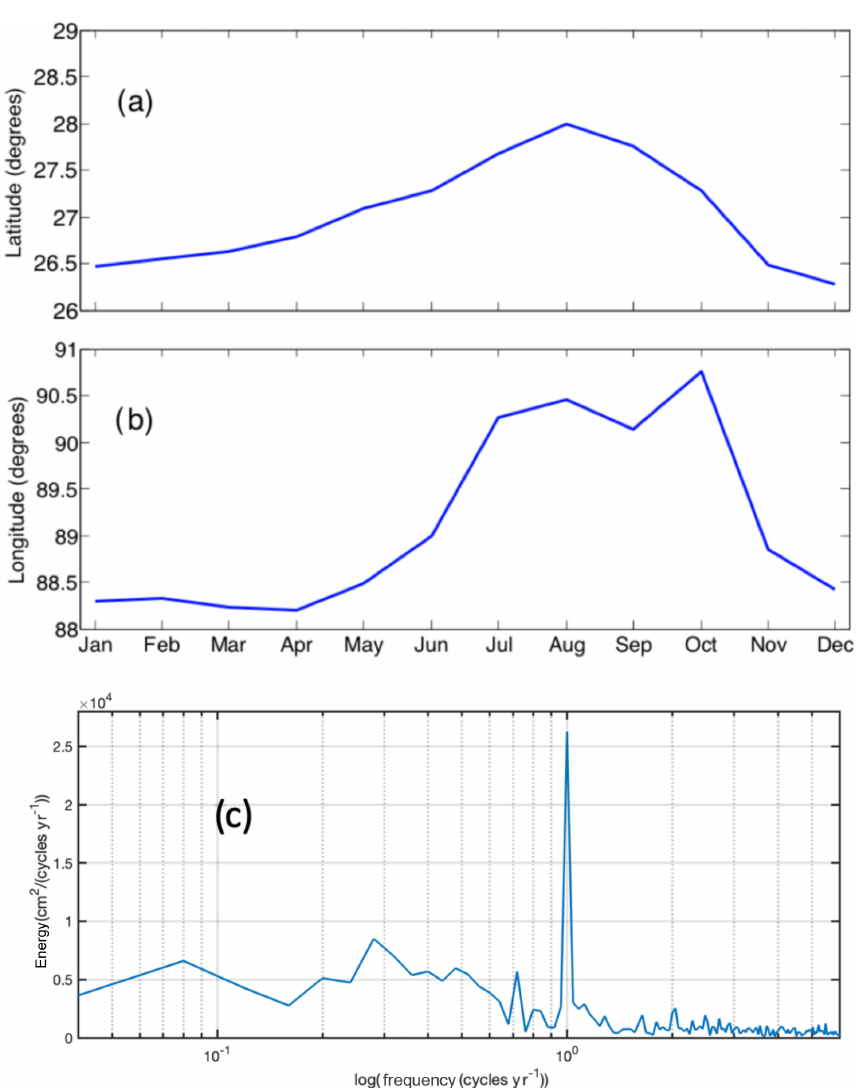
Figure 3. Geographical positions of the CWF tracked using the 40cm ADT isoline representing 1993–2017 monthly average values: (a) northward and (b) westward, respectively; (c) ADT spectral analysis in a region influenced by the CWF (91.25 ◦ W, 23.125 ◦ N and 83.5 ◦ W, 28.12 ◦